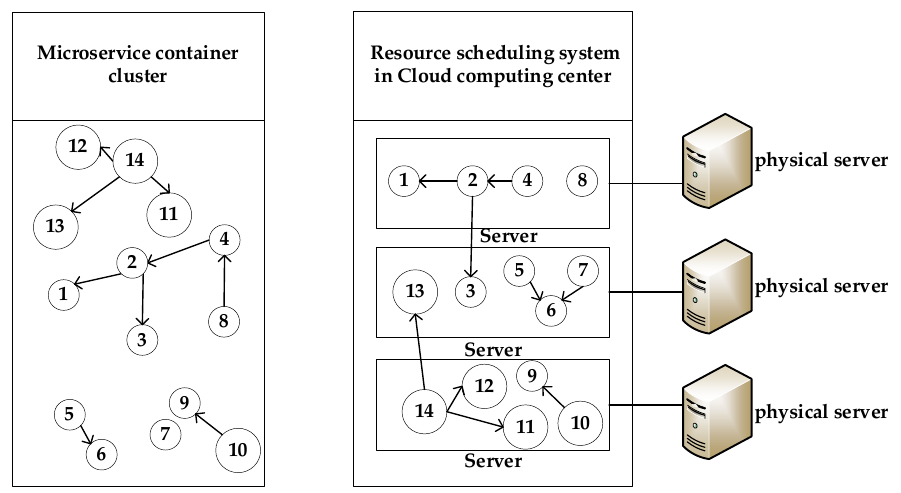
Figure 2. Schematic diagram of cloud microservice resource scheduling.